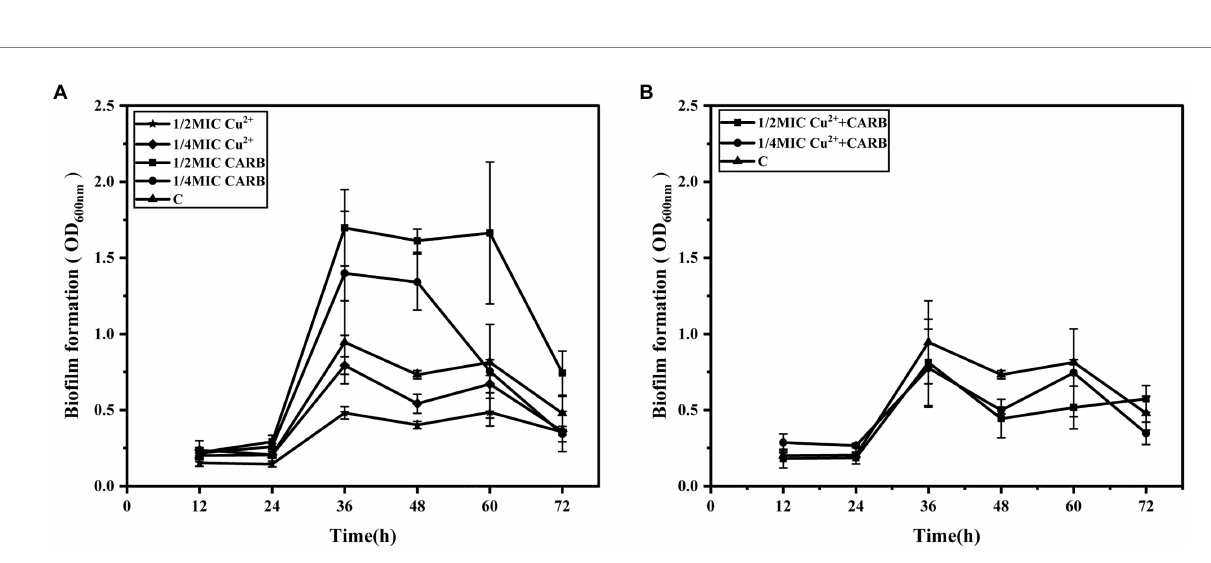
FIGURE 3 The dynamic process of biofilms formation by V. parahaemolyticus with time under different treatment conditions. (A) 1/2 and 1/4 MIC Cu 2+ treatment, 1/2 and 1/4 MIC CARB treatment, (B) 1/2 and 1/4 MIC Cu 2+ +CARB